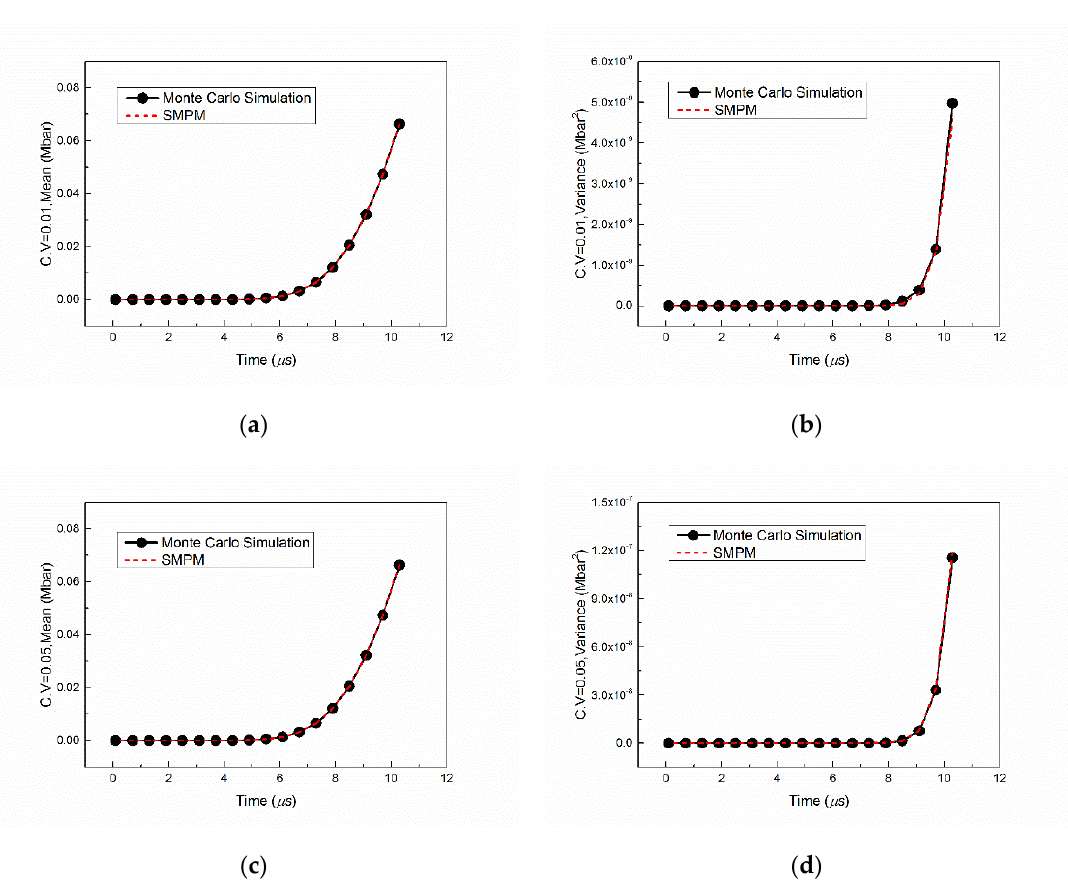
Figure 5. Pressure * p response of location E by various methods with C.V = 0.01 and C.V = 0.05: ( a ) Mean of pressure * p with C.V = 0.01; ( b ) Variance of pressure * p with C.V = 0.01; ( c ) Mean of pressure * p with C.V = 0.05; ( d ) Variance of pressure * p with C.V = 0.05.